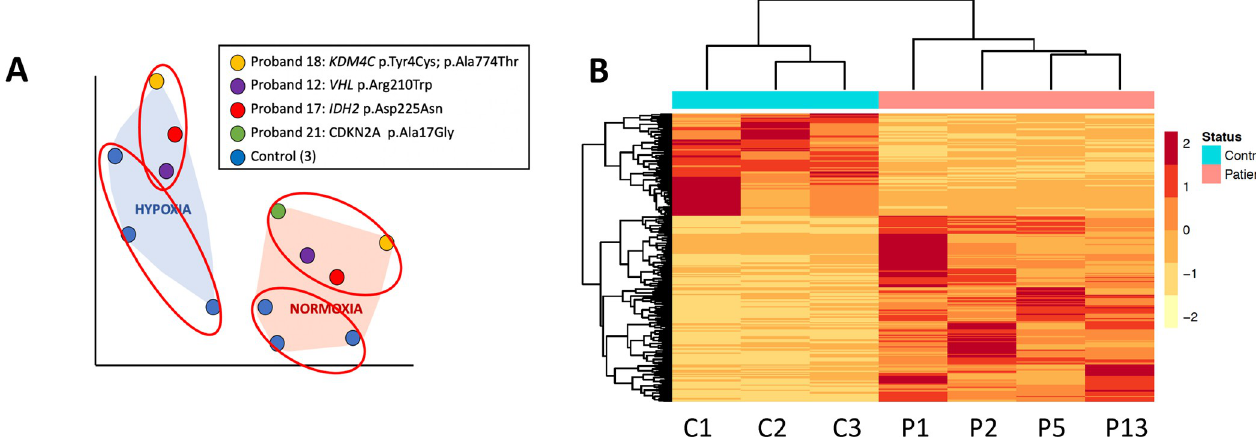
Fig 2. RNA-seq analysis shows differentially expressed genes between proband and control groups. A. T-SNE shows clusters based on hypoxia treatment and whether the sample is from a proband or a control. B. Heatmap of significant (p < 0.05) differentially expressed genes in 4 probands at normoxia vs. 3 controls at normoxia. Proband numbers (P1-P4) correspond to Table